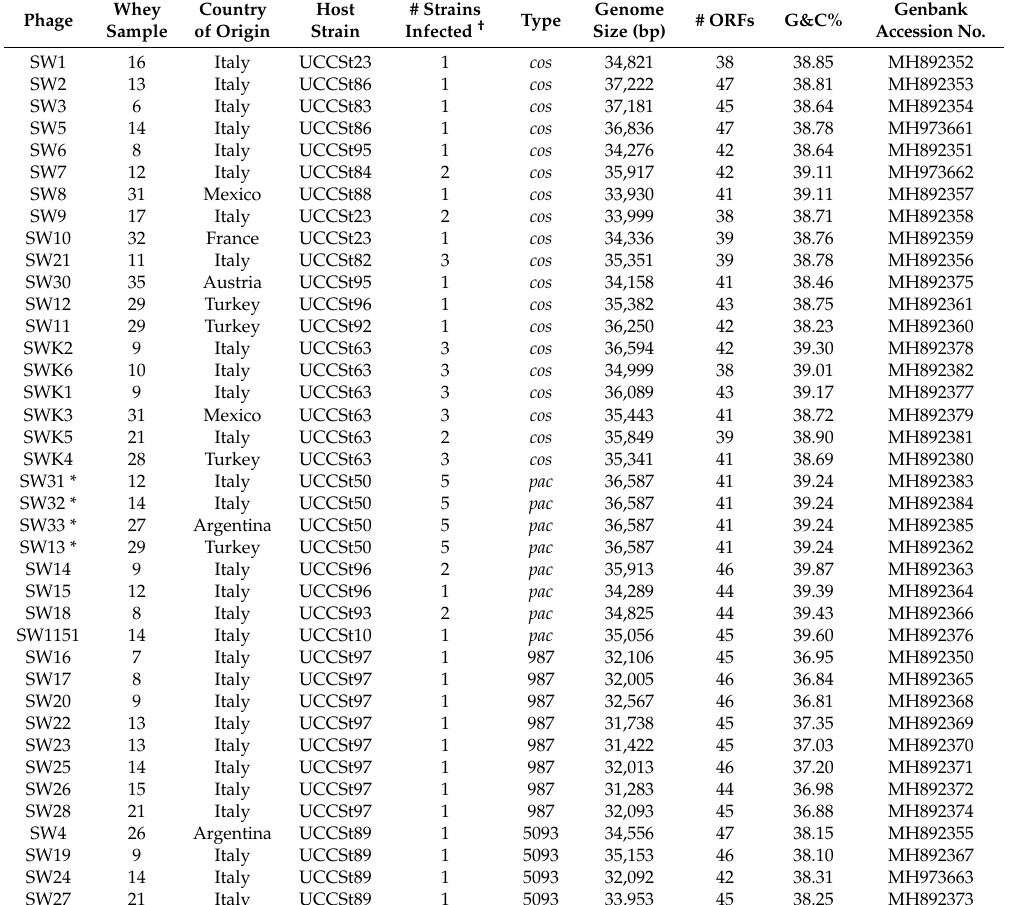
Table 2. Summary of the genome characteristics of the sequenced S. thermophilus phage genomes. ORF—open reading